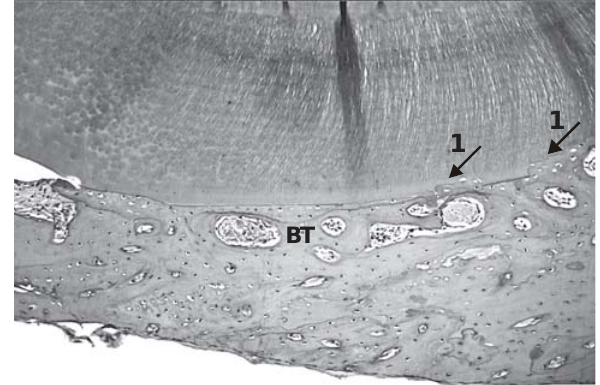
FIGURE 1- Extension of root involvement by resorption